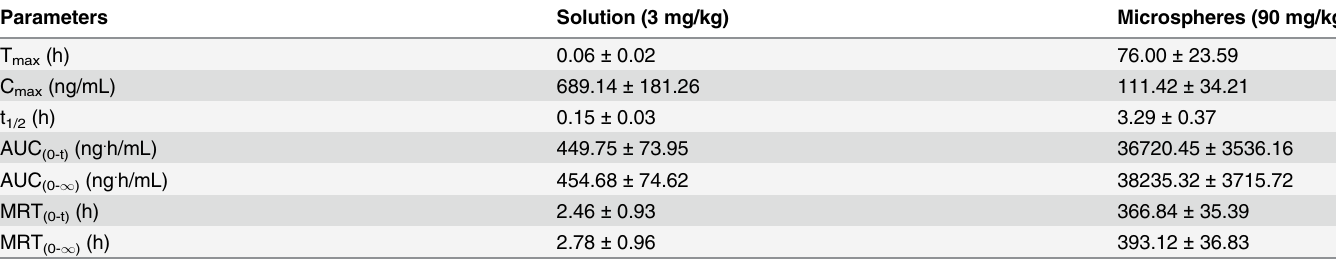
Table 1. Pharmacokinetic parameters after single subcutaneous injection of nalmefene solution and microspheres in rats (n = 6).